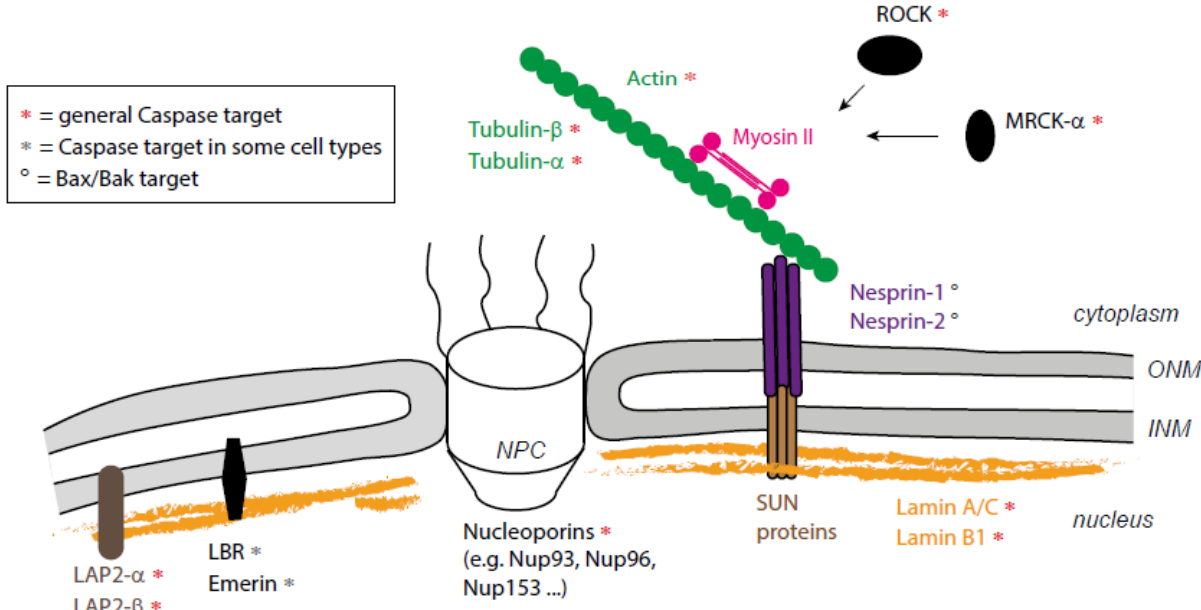
Figure 1. Caspase targets involved in cytoskeleton/nucleus coupling. Schematic representation of the interface between the cytoplasm and the nucleus. Caspases’ targets are indicated by stars. NPC, Nuclear Pore Complex; INM, Inner Nuclear Membrane; ONM, Outer Nuclear Membrane.